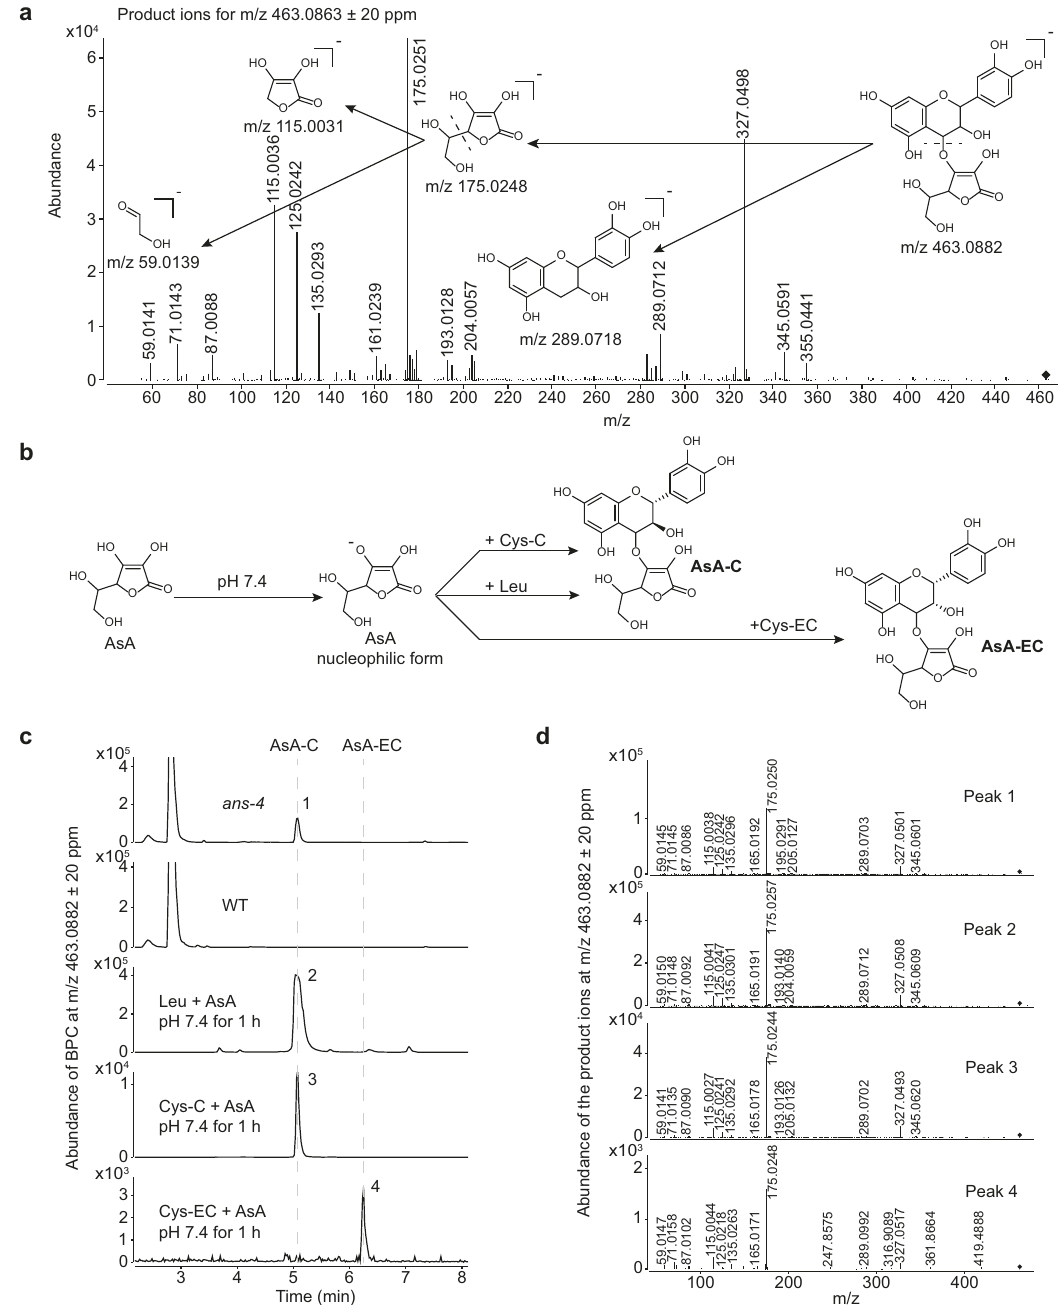
Fig. 4 The candidate compound is AsA-C. a Product ions for fragmentation of the catechin conjugate of m/z at 463.0863 ± 20 ppm and deduction of its fragmentation mode. Theoretically calculated m/z values are labeled under the corresponding structures. b Scheme for the chemical synthesis of AsA-C and AsA-EC in vitro. c Comparison of the retention time of the precursor ions at m/z 463.0882± 20 ppm between the A. thaliana ans-4 extract and the product of the chemical reaction. d Product ions of compounds marked in ( c by ultra-high performance liquid chromatography-triple quadru- In the same way, we detected two compounds matching the MS/ pole mass spectrometry (UHPLC-QqQ) with multiple reaction MS pro fi le of AsA-C-C-C-C (pentamer) in the ans-4 mutant monitoring (MRM) of the transition of [M-H] − m/z 1327.3 to (Supplementary Fig. 6a, b). However, the instrument sensitivity for [(C 15 H 12 O 6 ) 4 - H] − m/z 1151.2. Two peaks representing pentamers capturing the pentamer precursor ion was too low (Supplementary were clearly detected in the ans-4 and AsA + Leu samples but not Fig. 6a), re fl ecting the common challenge of characterizing typical in the WT (Supplementary Fig. 6c), suggesting that the MRM PA polymers by LC/MS 29,30 . As AsA-[C] n could yield a series of approach could improve the sensitivity for detecting AsA fragments [(C 15 H 12 O 6 ) m - H] − (0 < m ≤ n) resulting from QM fi ssion during the IFL cleavage or the leaving of the AsA moiety conjugates with higher molecular weight. We then used MRM (Supplementary Fig. 6b), we re-analyzed soluble PAs from ans-4 , transitions of m/z (1615.3 → 1151.2), m/z (1904.4 → 1151.2), and together with WT samples and products of AsA + Leu incubation, m/z (2192.5 → 1727.4) with optimized MS parameters to analyze